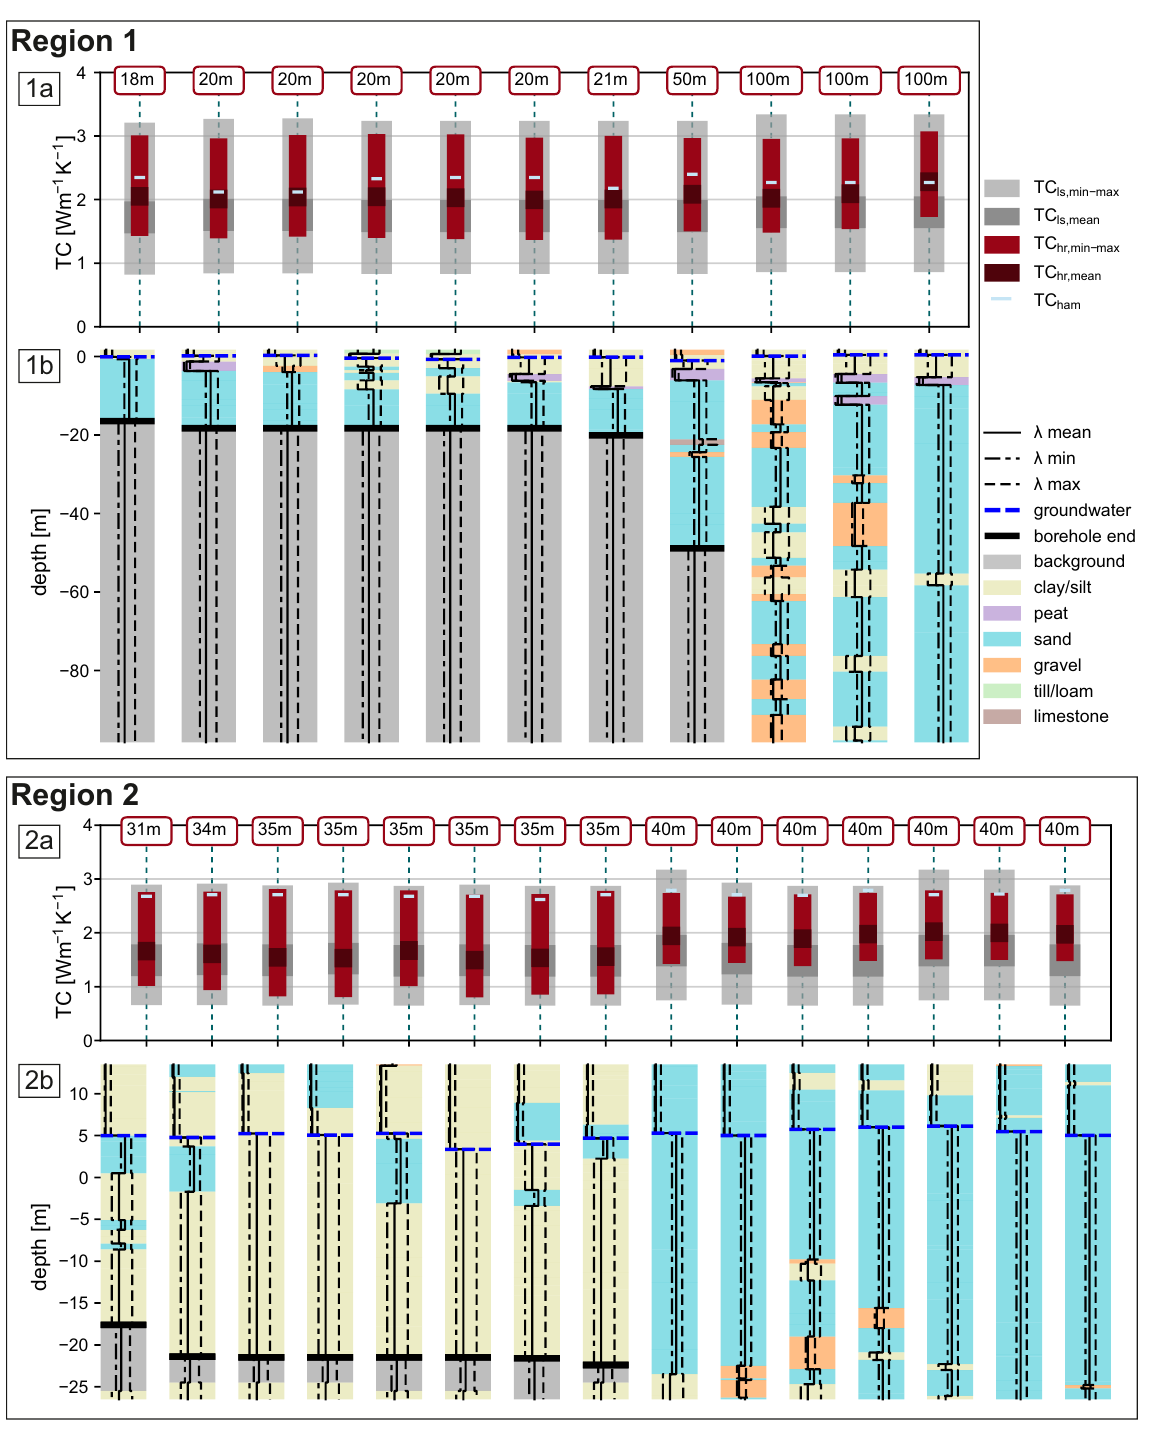
Figure 8. ( 1a , 2a ): Mean, min, and max TC value predicted at each borehole in region 1 ( top ) and region 2 ( bottom ) shown in red, and comparison to TC ls (gray bars) and TC ham as blue lines. ( 1b , 2b ): Corresponding borehole and TC profiles. The x-axis of the TC profiles ranges from 0 to 4 Wm − 1 K − 1 . For visualization purposes, we show only the 15 longest of in total 53 boreholes in region